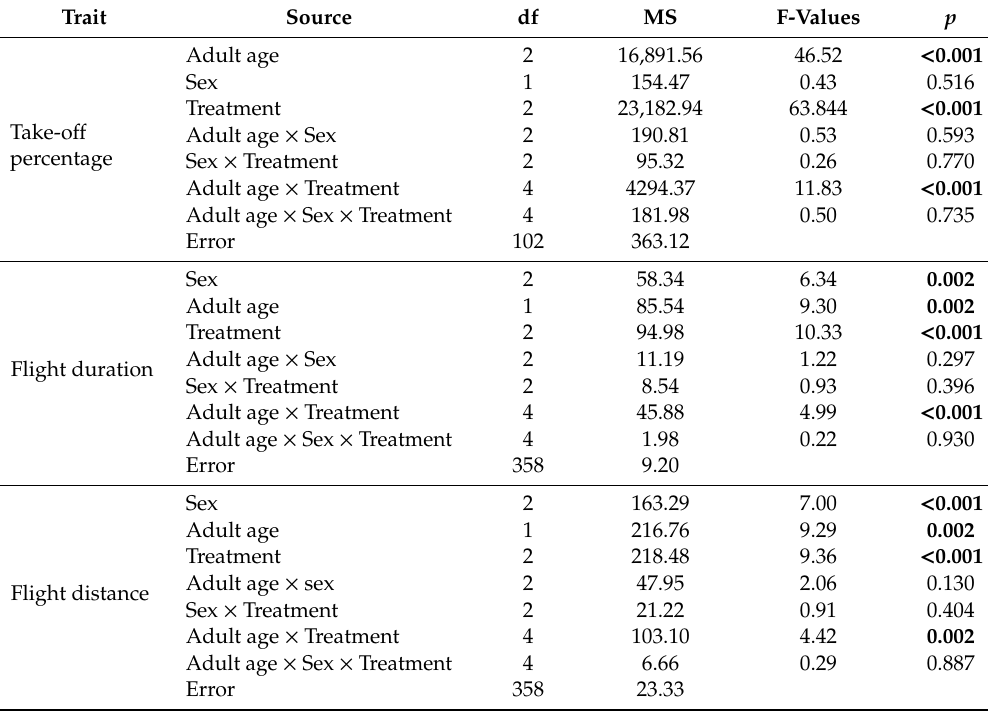
Table 2. Three-way ANOVA for the e ff ects of di ff erent treatments on take-o ff percentage, flight duration and flight distance in Cnaphalocrocis